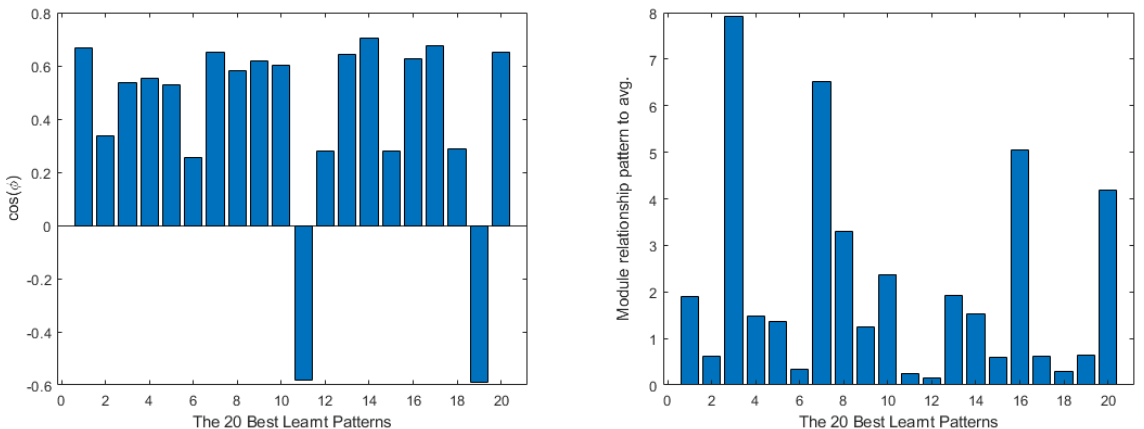
(cid:12) (cid:12) 𝜕𝐿𝑜𝑠𝑠 ∂ Loss | relationship to the average (cid:12) (cid:12) (cid:12) (cid:12) relationship to the average ∂ W n 𝜕𝑊 𝑛